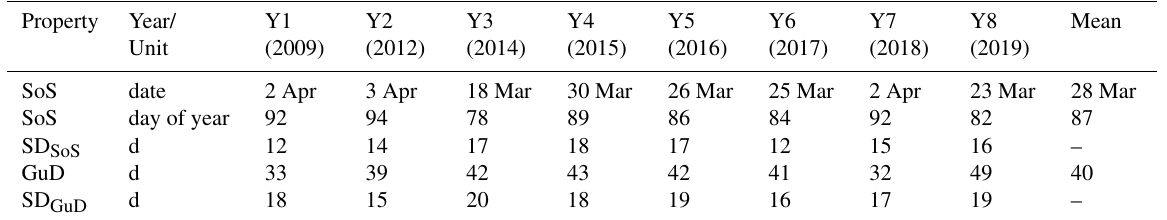
Table 3. Start of spring (SoS) with its SD (SD SoS ) and the green-up duration (GuD) with its SD (SD GuD ) for all vegetation within a 100km diameter circular area of Budapest for all measurement years. The years in parentheses indicate the calendar year of the spring. Property SoS